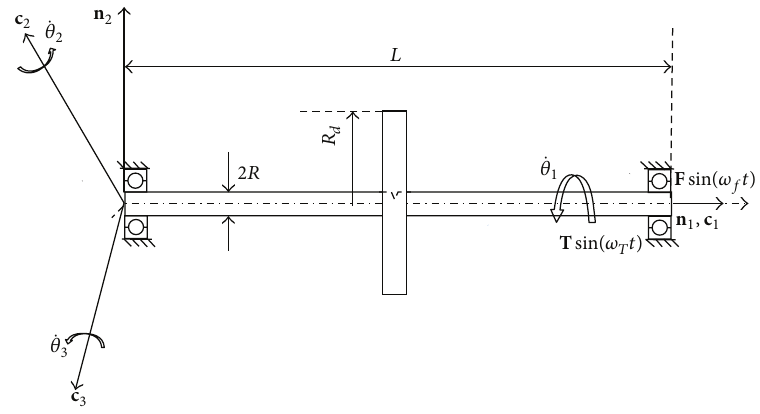
Figure 1: Cracked Jeffcott